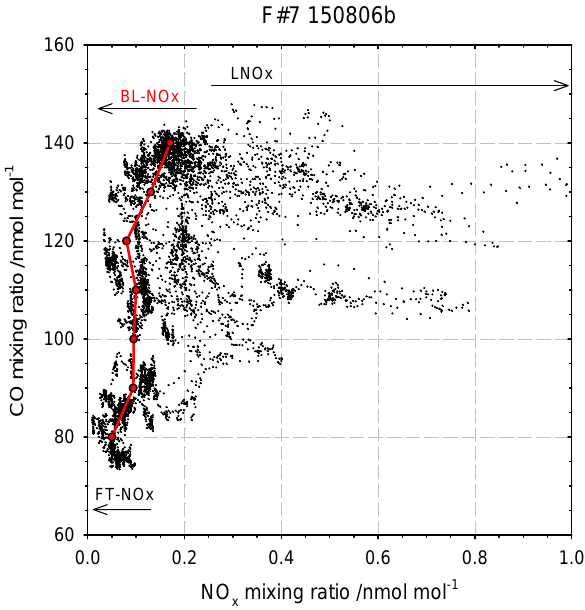
Fig. 12. NO x -CO correlation plot for the Falcon b-flight on 15 August 2006. The NO x contributions from the free troposphere (FT), boundary layer (BL) and from production by lightning ( LNO x ) are indicated. The red line indicates the changing NO x contribution from the BL and FT depending on CO mixing ratios.